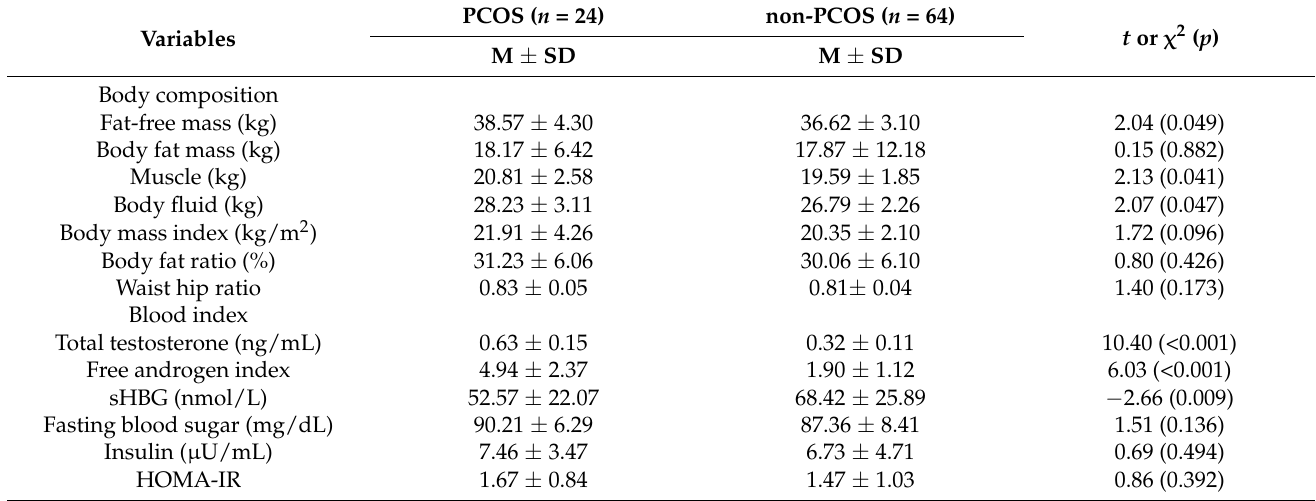
Table 5. Body composition and blood indexes among women with PCOS or not ( n =